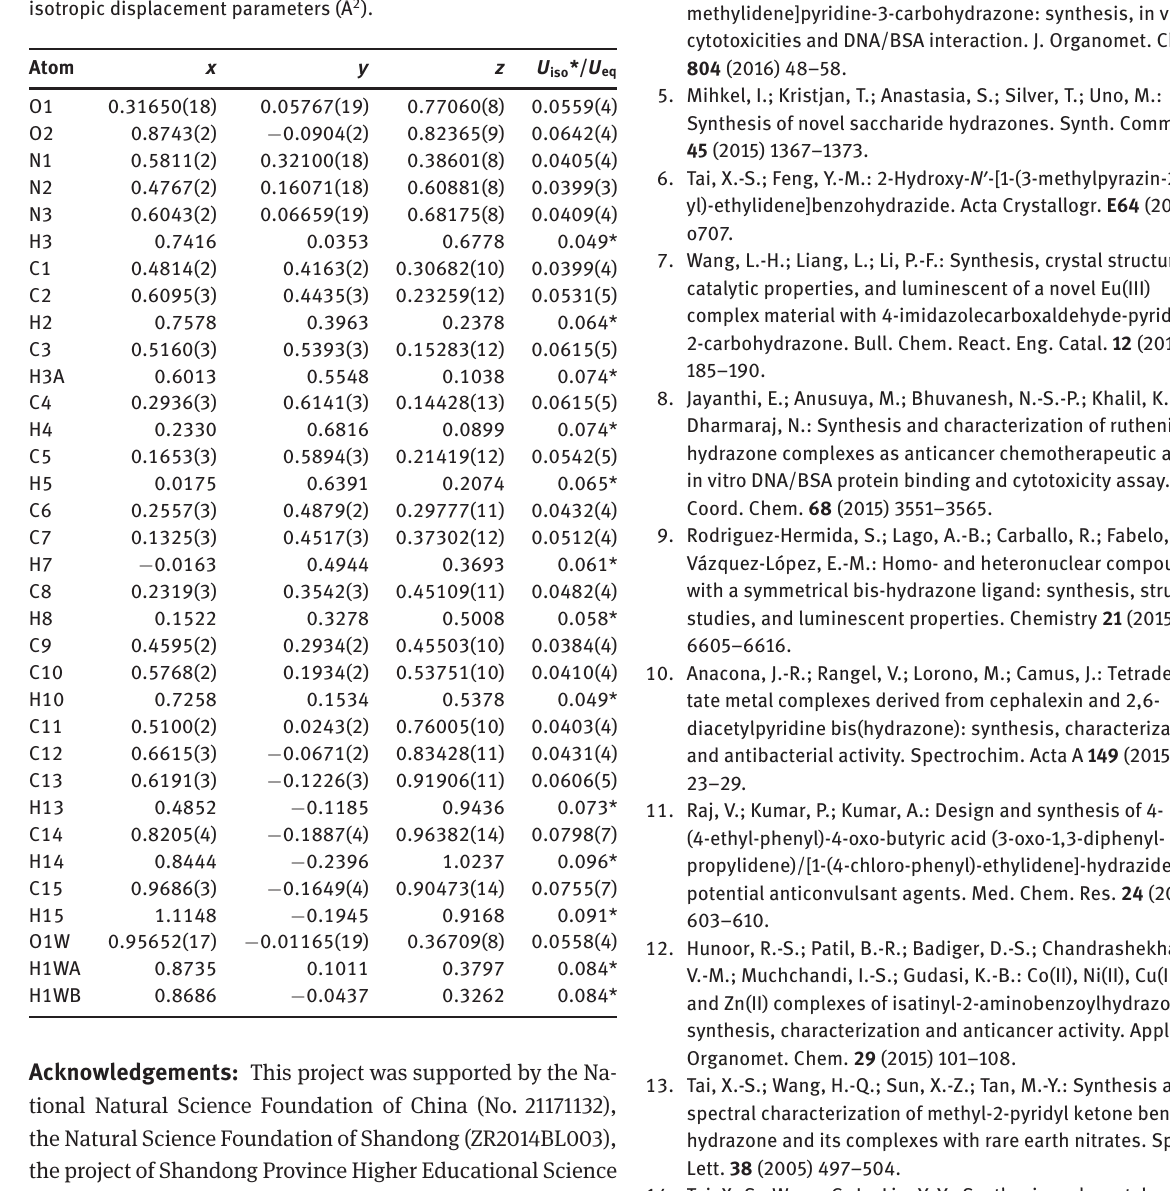
Table 2: Fractional atomic coordinates and isotropic or equivalent isotropic displacement parameters (Å 2